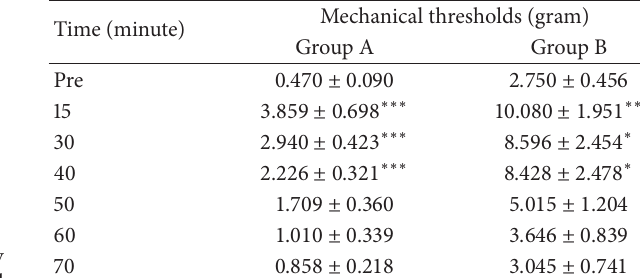
Table 1: Mechanical threshold measurement comparisons for Groups A and B at various time points: before (Pre), during (15 and 30 minutes), and after (40, 50, 60, and 70 minutes) motor cortex stimulation. Motor cortex stimulation began at 15min time point.